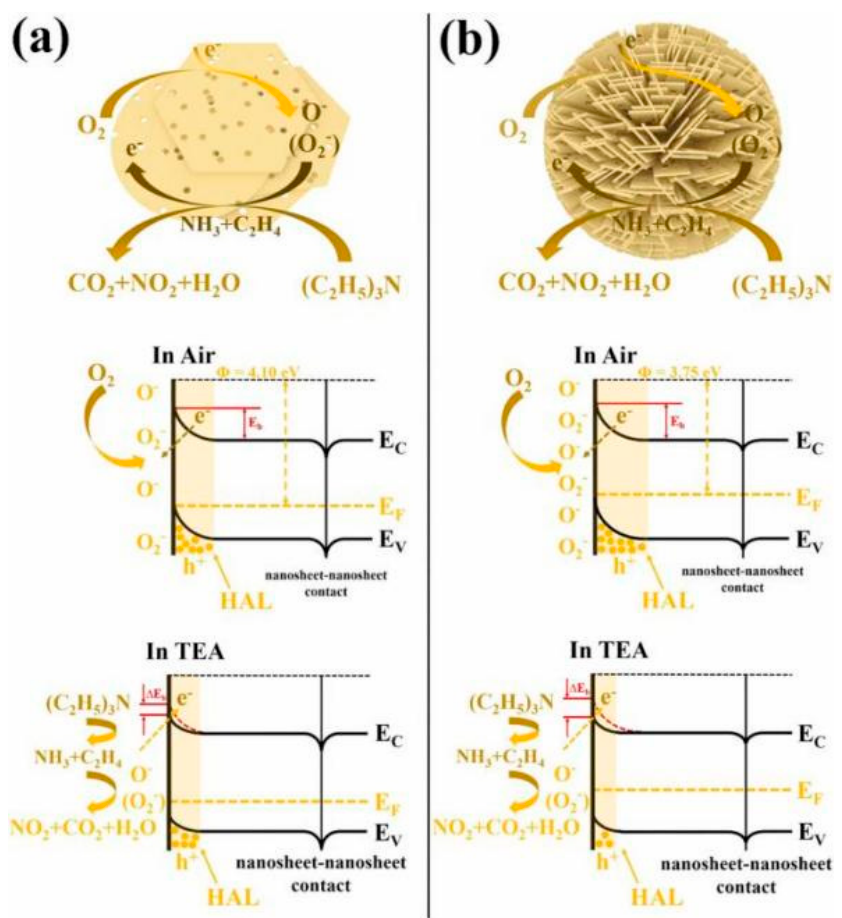
Figure 3. Typical p-type gas-sensing mechanisms for ( a ) Co 3 O 4 sheet-300 and ( b ) Co 3 O 4 sphere-300 [43].